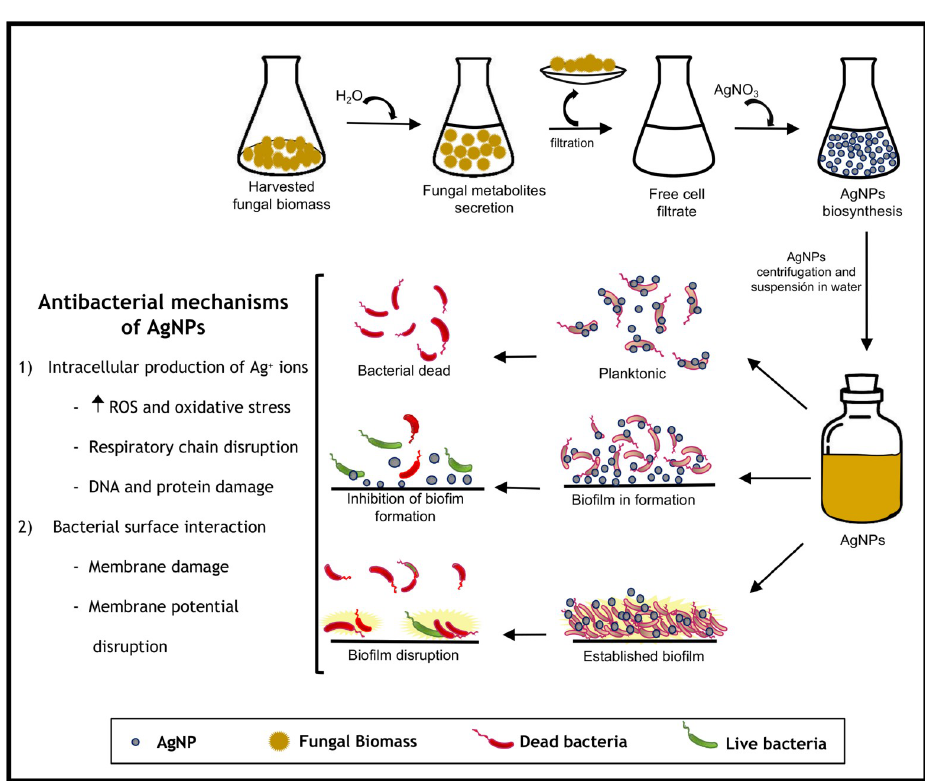
Fig 11. Schematic methodology of AgNPs synthesis, antimicrobial activity against UPEC biofilms and possible mechanisms involved.